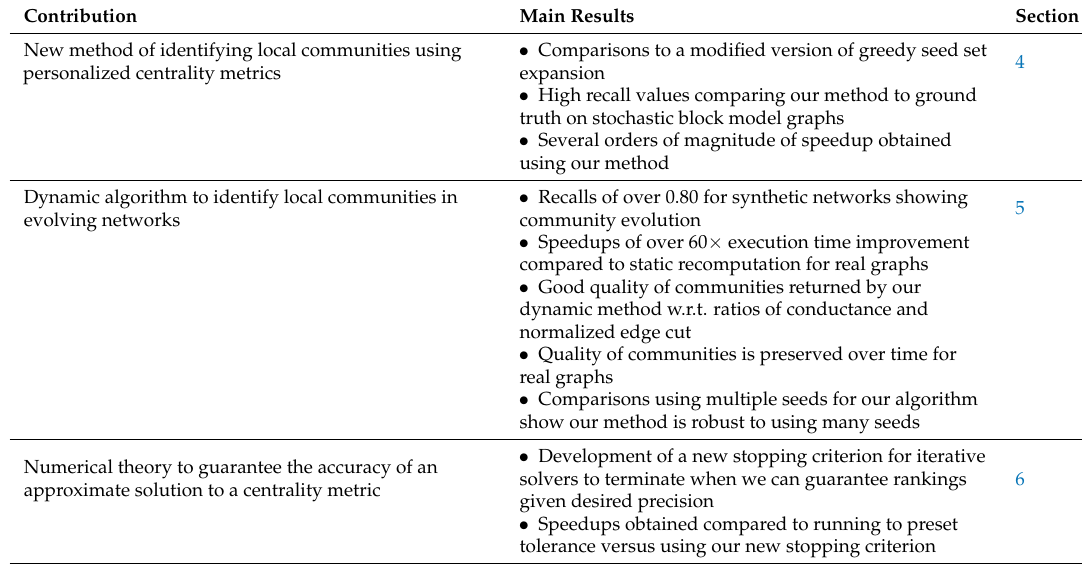
Table 1. Contributions and main results presented in this